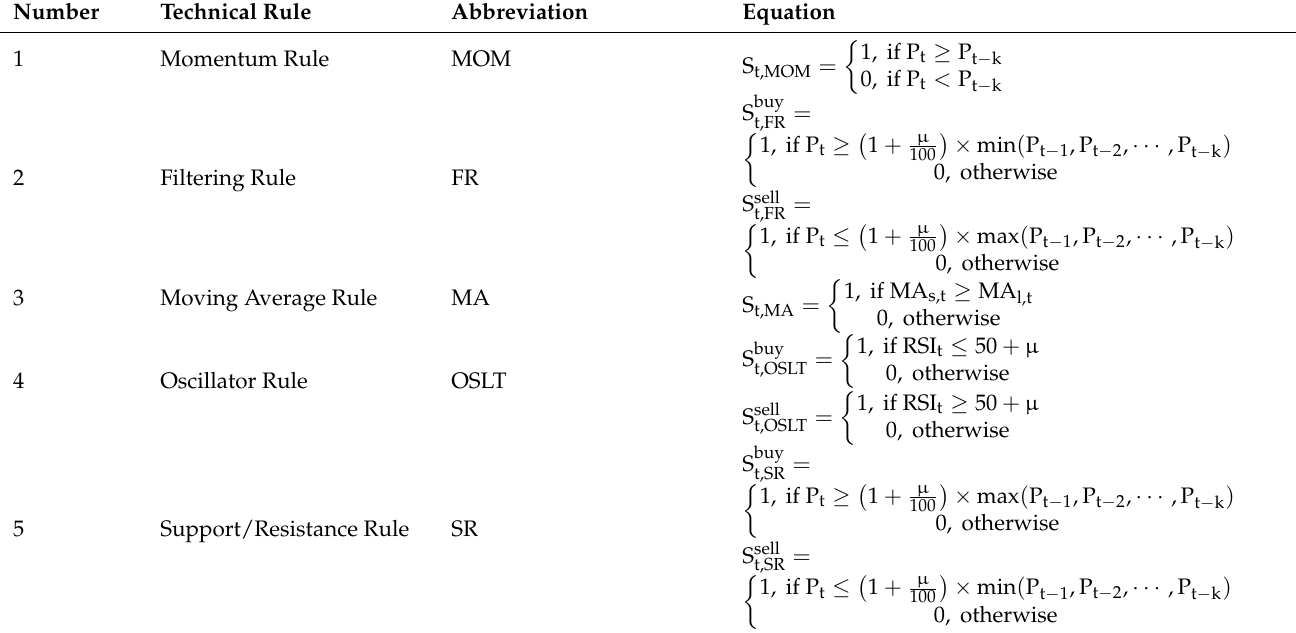
Table 1. Description ff technical